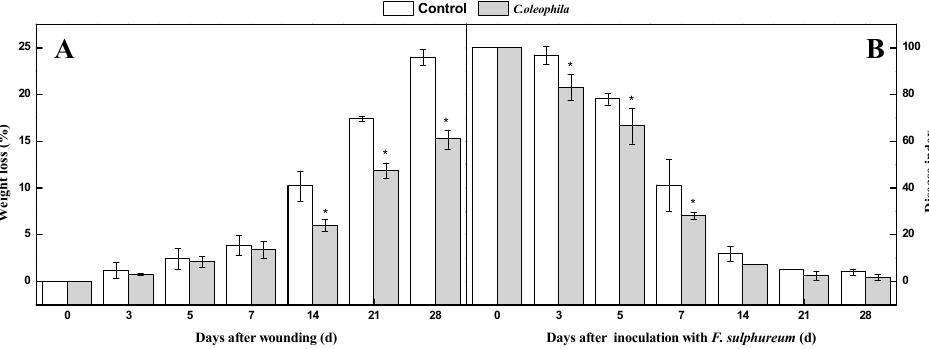
Figure 1. Effect of C. oleophila treatment on weight loss ( A ) and disease index ( B ) of tuber during healing. Bars indicate standard error (±SE). Asterisks indicate significant difference ( p < 0.05).